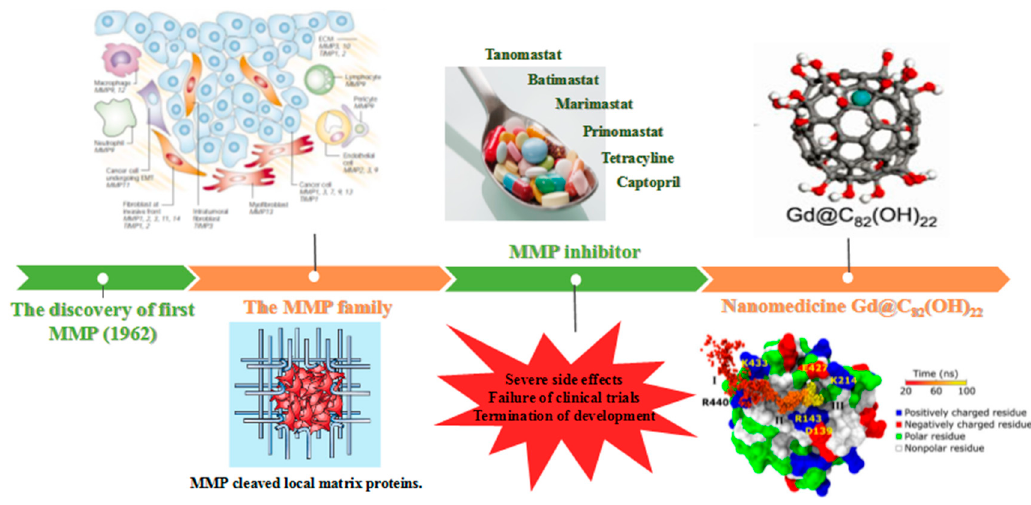
Figure 4. A brief history of MMP-based discovery: From MMP inhibitors to Gd@C 82 (OH) 22 . After the